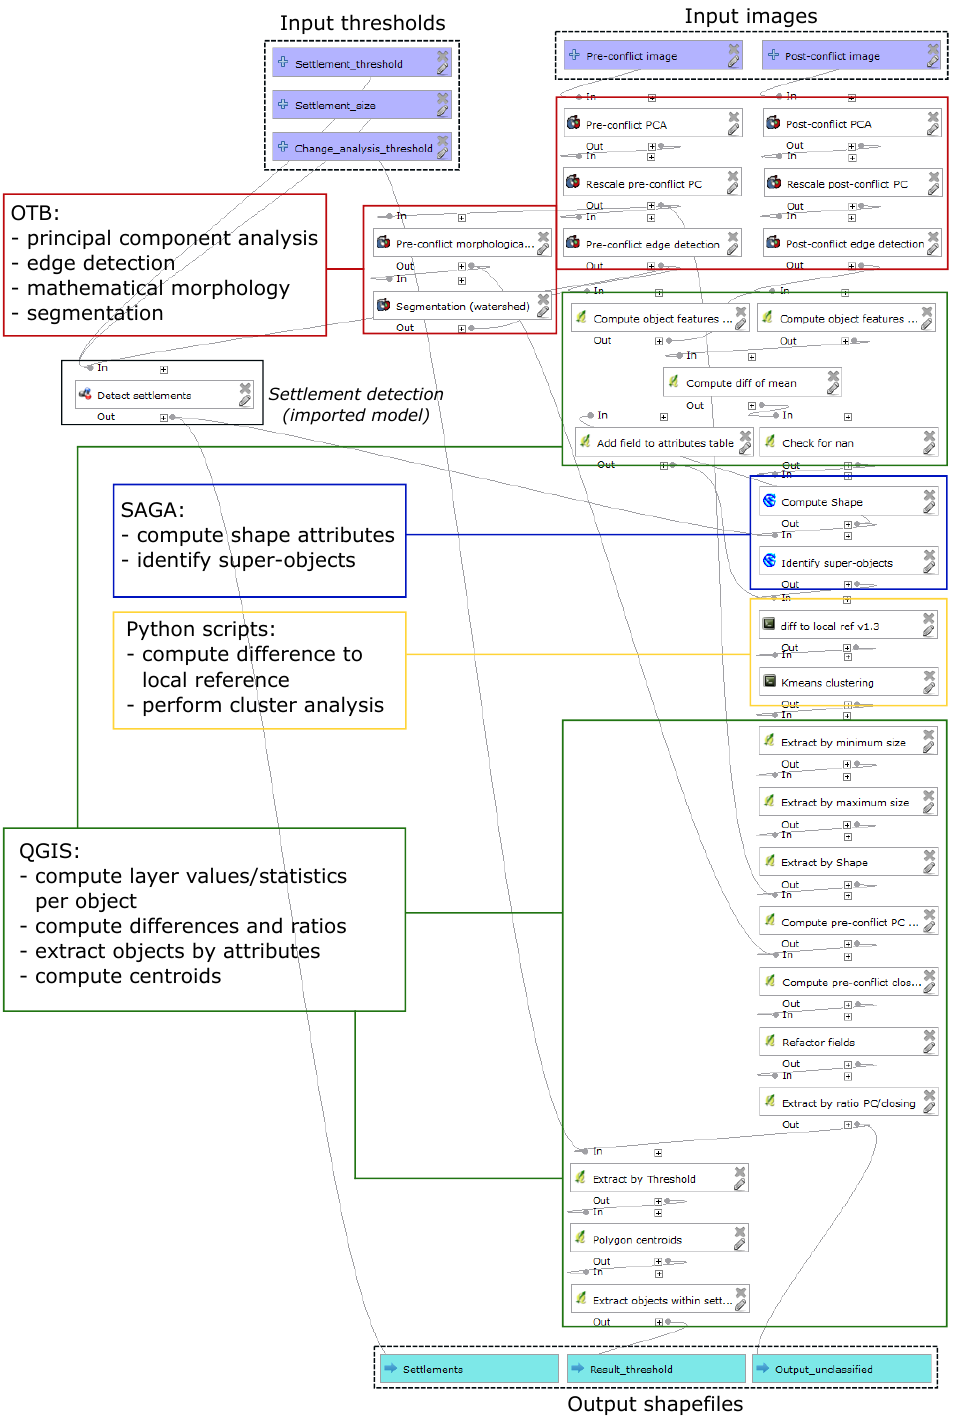
Figure 3. Screenshot of the QGIS graphical workflow modeler showing the example change analysis. Two input images and three numerical parameters are shown in purple boxes at the top. The inputs, processing steps and outputs are connected by grey arcs and roughly ordered from top to bottom. The analysis steps are based on four libraries highlighted by the colored boxes: OTB (red), QGIS (green), SAGA GIS (blue) and Python (yellow). A detailed view of the sub-model detect settlements (grey, left hand side) is in Figure A2. At the bottom, the three output shapefiles are shown in turquoise